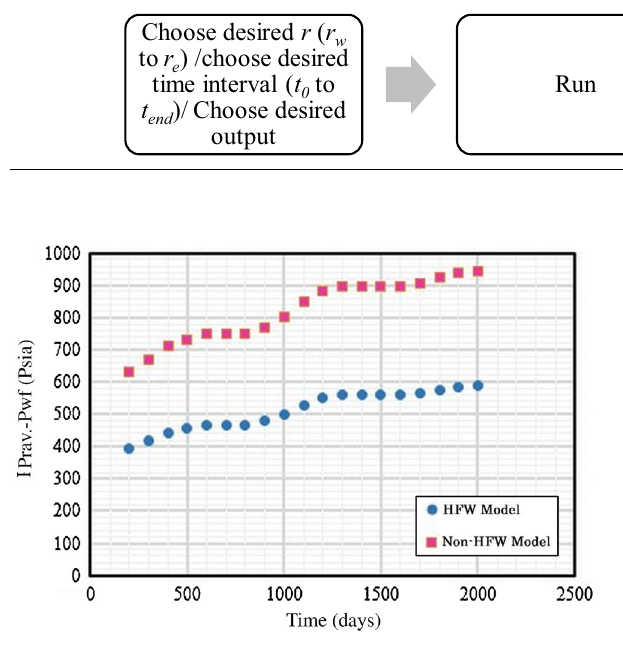
Fig. 14 Comparison of the HFW with the non-HFW model